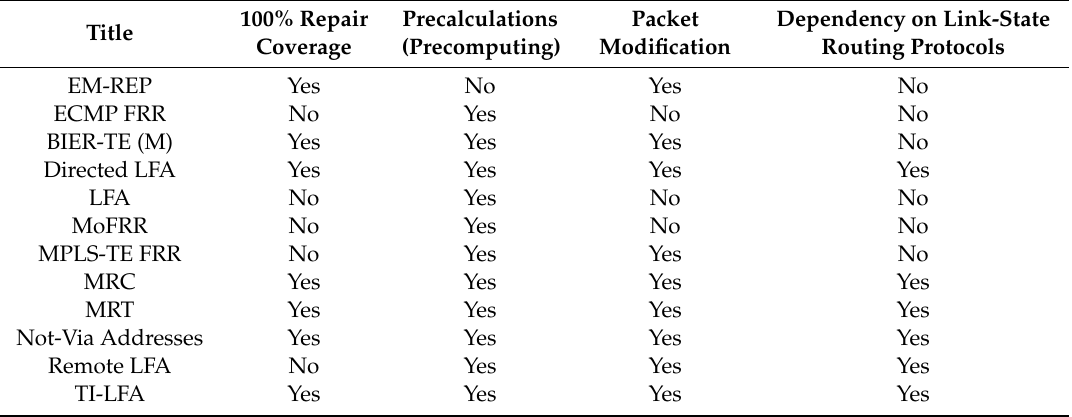
Table 7. Comparison of the innovative M-REP mechanism with existing